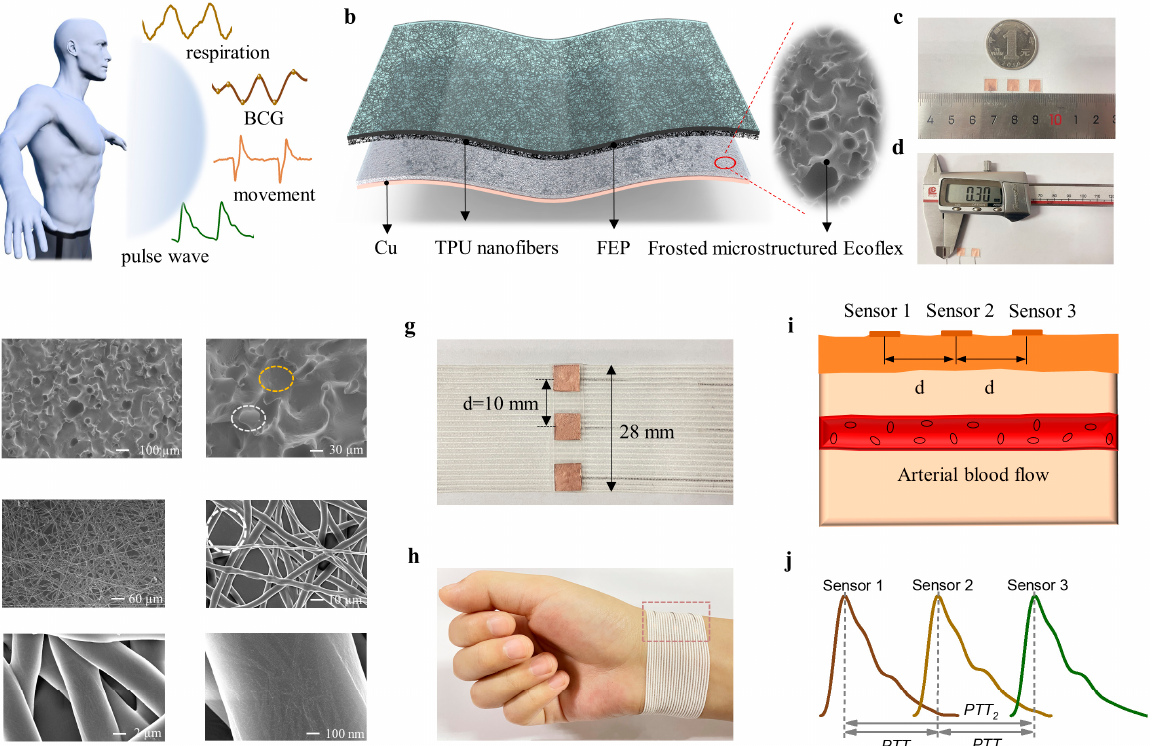
Figure 1. Construction of the sensor array. ( a ) Different kinds of human physiological signals include respiration, BCG, movement, and pulse wave. ( b ) Schematic structure diagram of the single sensor. ( c , d ) The dimension of sensor. ( e ) The SEM images of the frosted microstructured Ecoflex film, which consists of groove (marked by orange dotted box) and convex (marked by white dotted box). ( f ) The SEM images of the TPU nanofibers fabricated on the FEP surface. ( g ) The optical image of 3 × 1 flexible pressure sensor array and relative position relationship. ( h ) Photograph of a sensor array on the subject’s wrist to capture human epidermal pulse waves. ( i ) The sensor array placement configuration and human artery simplified diagram. ( j ) Schematic diagram of three pulse signals of radial artery position.